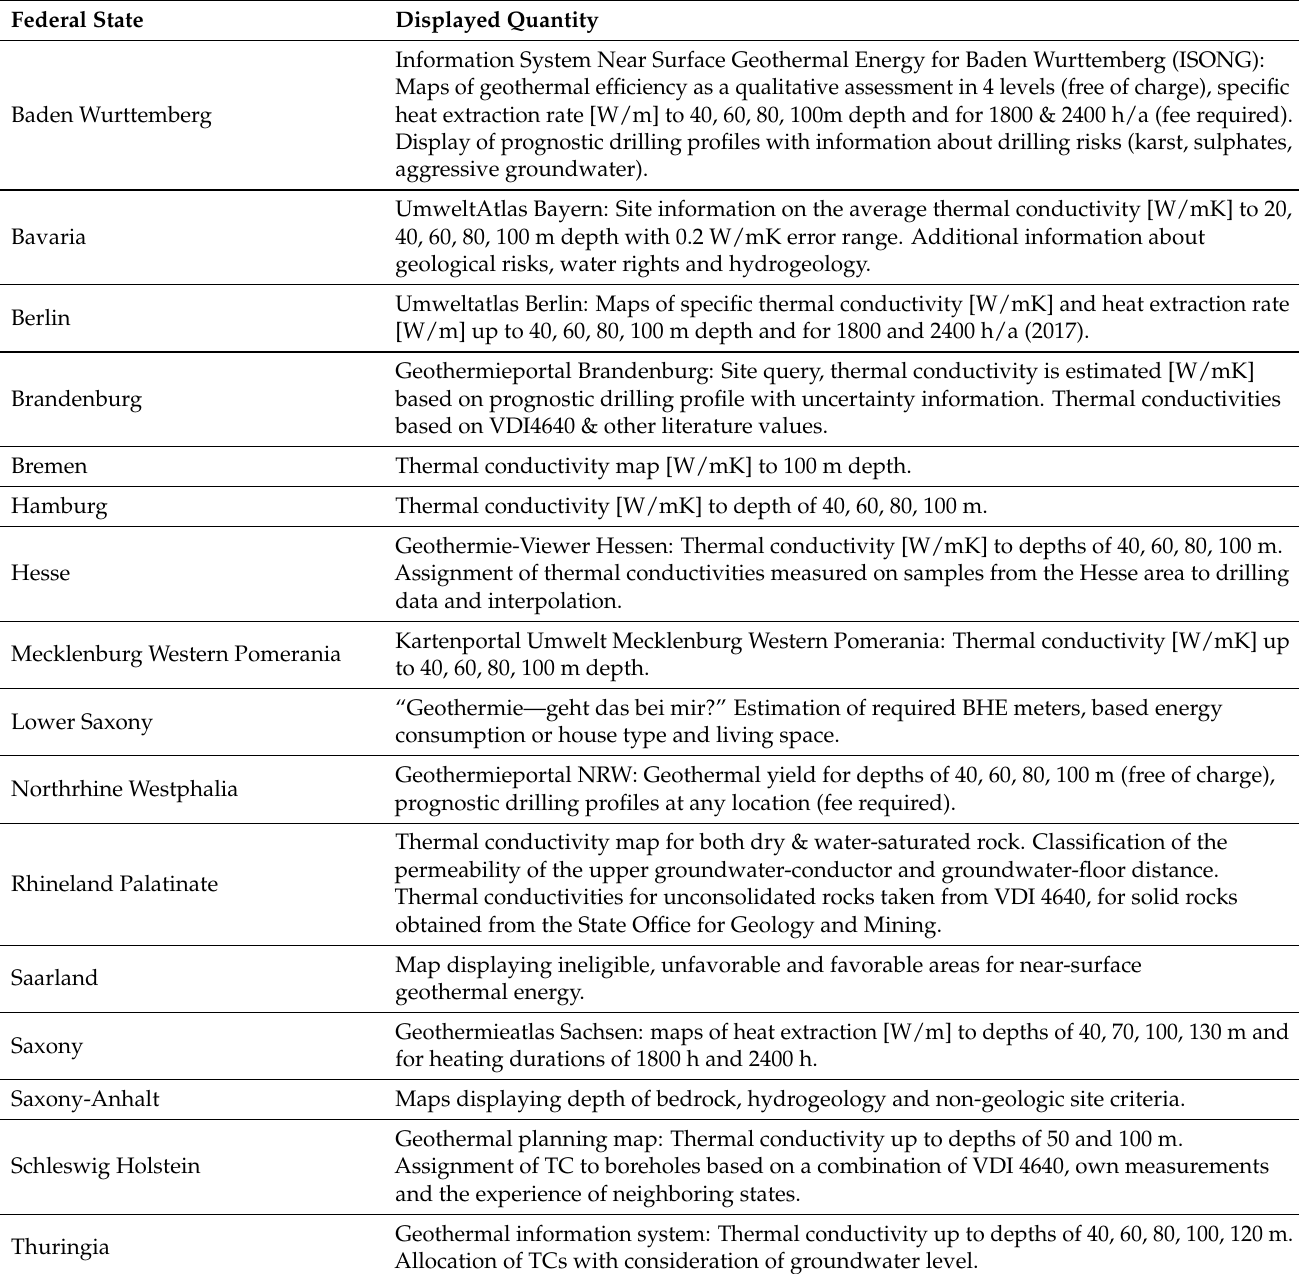
Table A1. Overview of the information base on near-surface geothermal energy in the German